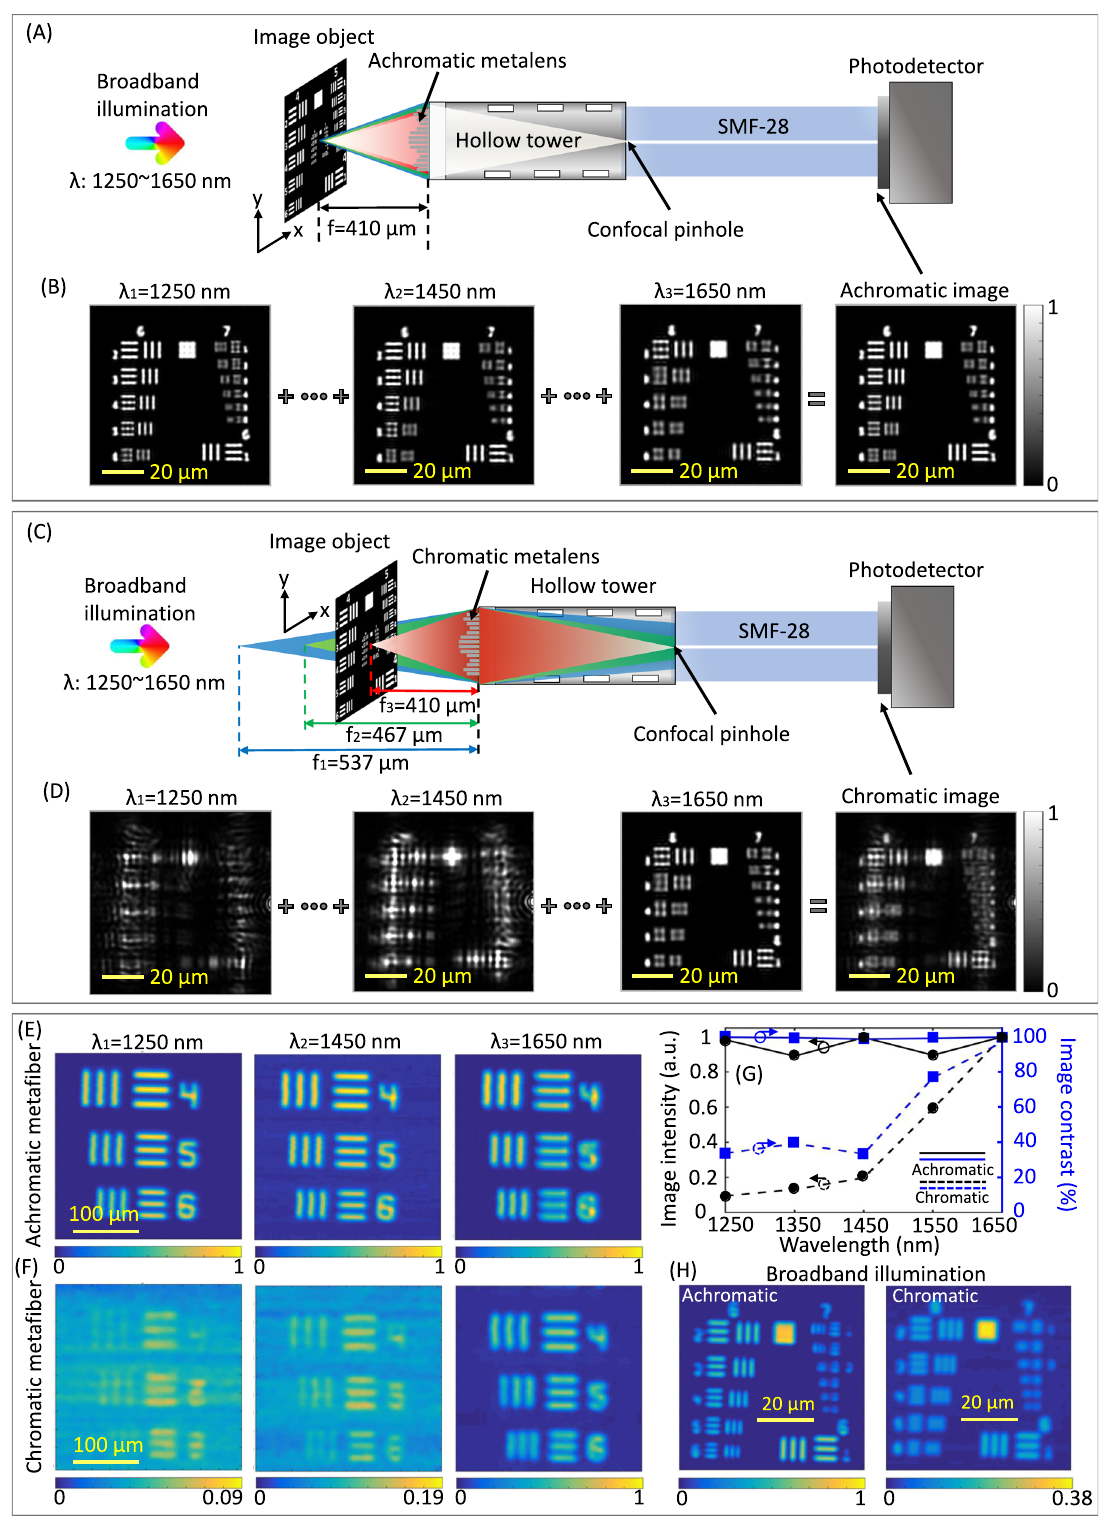
Fig. 5 Imaging performance of an achromatic meta fi ber. A – D Simulated confocal imaging results of the 1951 USAF resolution test chart (Groups 6 and 7) under broadband illumination, based on achromatic ( A , B ) and chromatic ( C , D ) metalenses-implemented SMFs, respectively. E , F Experimentally obtained confocal imaging results of the USAF resolution test chart (Group 5, Elements 4 – 6) based on the E achromatic and F chromatic meta fi bers at different wavelengths. G Averaged image intensity (black color) and image contrast (blue color) of the experimentally obtained images at different wavelengths, based on the achromatic (solid lines) and chromatic (dashed lines) meta fi bers, respectively. H Experimentally obtained confocal imaging results based on the achromatic (left) and chromatic (right) meta fi bers under broadband illumination that consists of 8 equally spaced wavelength channels ranging from 1250 to 1650nm. We used the Group 6 Element 5 to mark the spatial resolution of our achromatic meta fi bre to be 4.92 µ m.